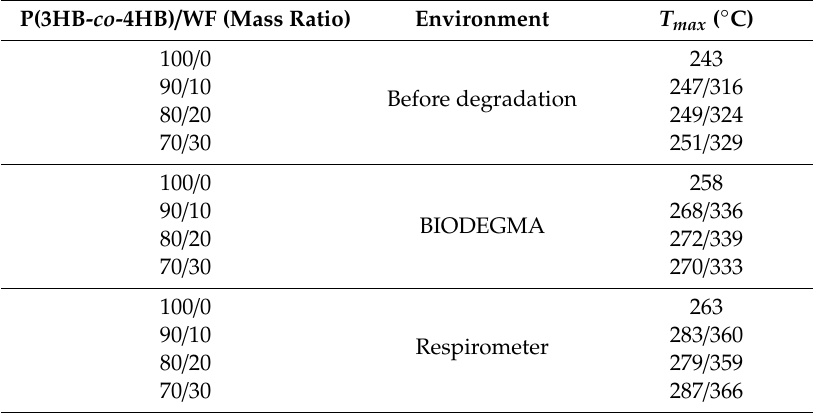
Table 4. Thermogravimetric parameters before and after 21 days of degradation of neat P(3HB- co -4HB) and P(3HB- co -4HB) / WF composites.